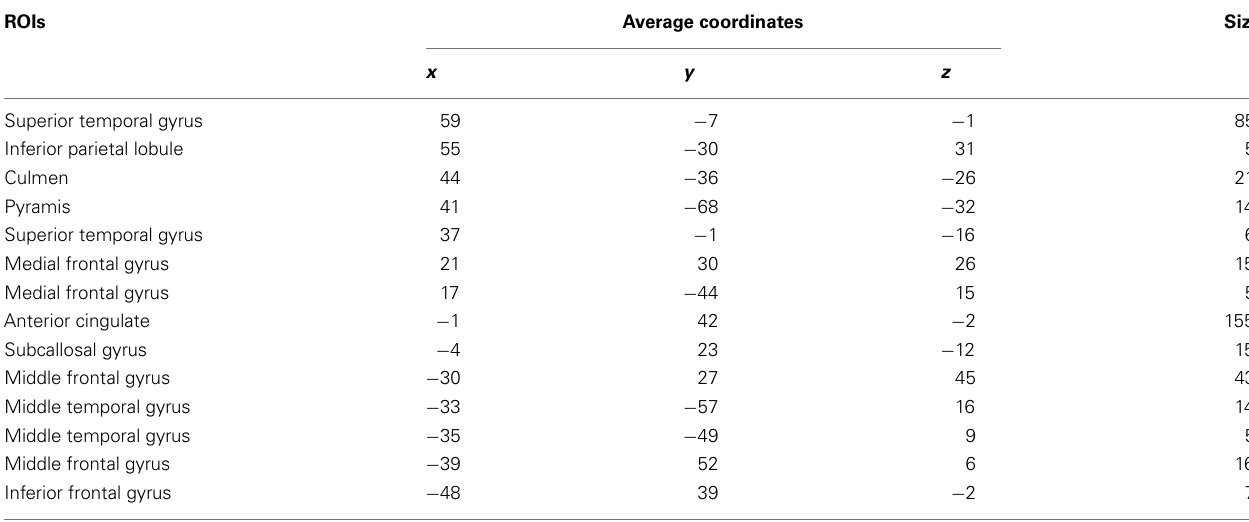
TableA2 |Areas in universal network for